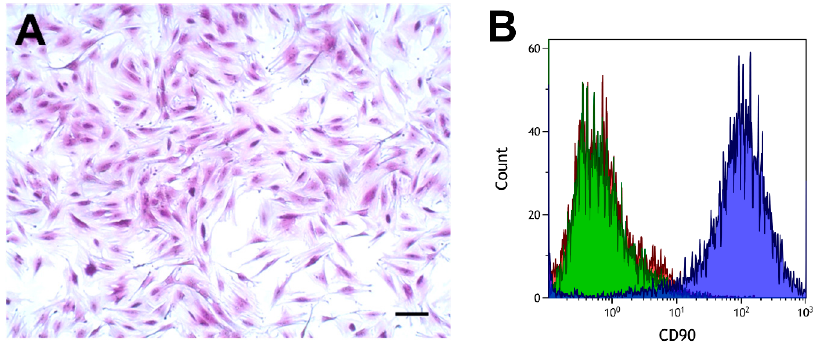
Figure 2. Morphology ( A ) and flow cytometry analysis of colorectal fibroblasts ( B ). ( A ) Crystal violet stain. Scale bar, 100 µm. ( B ) CD90, blue curve; IgG1 isotype control, green curve; phosphate-buffered saline (PBS), red curve.